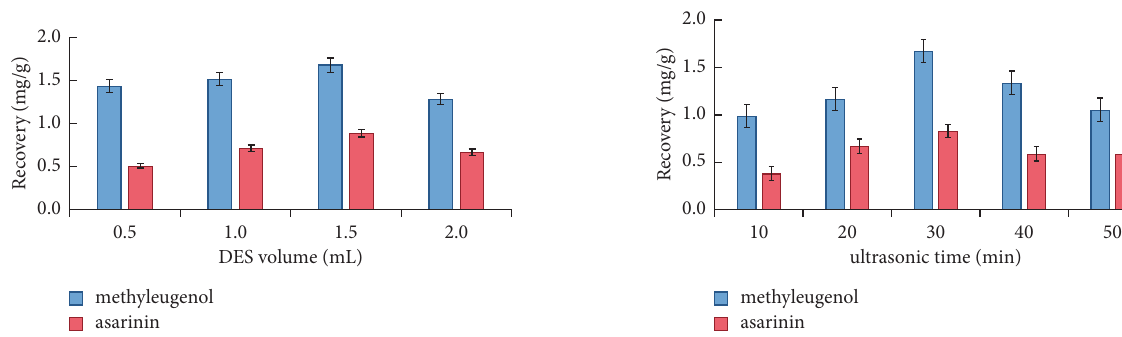
Figure 7: Effect of ultrasonic time, extraction conditions: sample amount, 50mg; molar ratio, 1:2; DES volume, 1.5 mL; ultrasonic temperature, 60 ° C; and vortex oscillation,